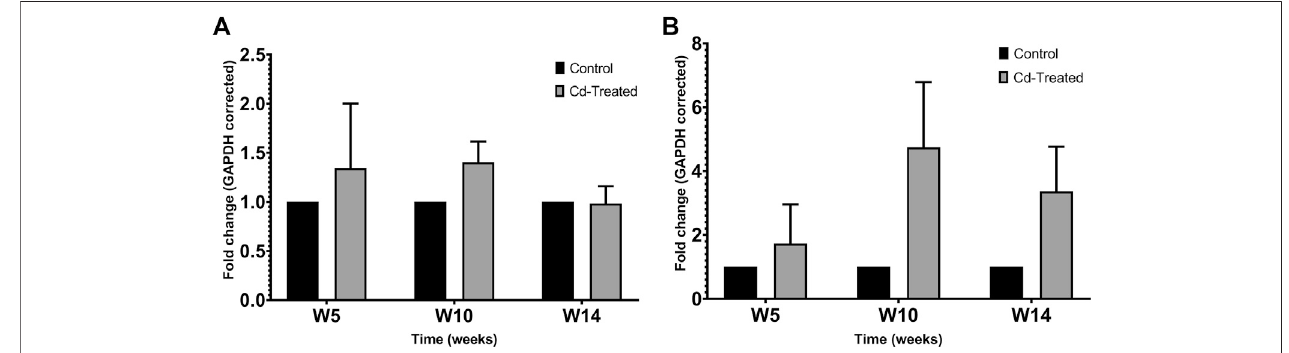
FIGURE 3| Effect ofCd-treatment on expression of TIMP in heart tissue ofmale Sprague-Dawley rats. Protein expression data of (A) TIMP-1and (B) TIMP-2 were normalized against the expression of GAPDH and expressed as mean ± S.E.M of fold-changes compared to the control ( n (cid:2) 8).